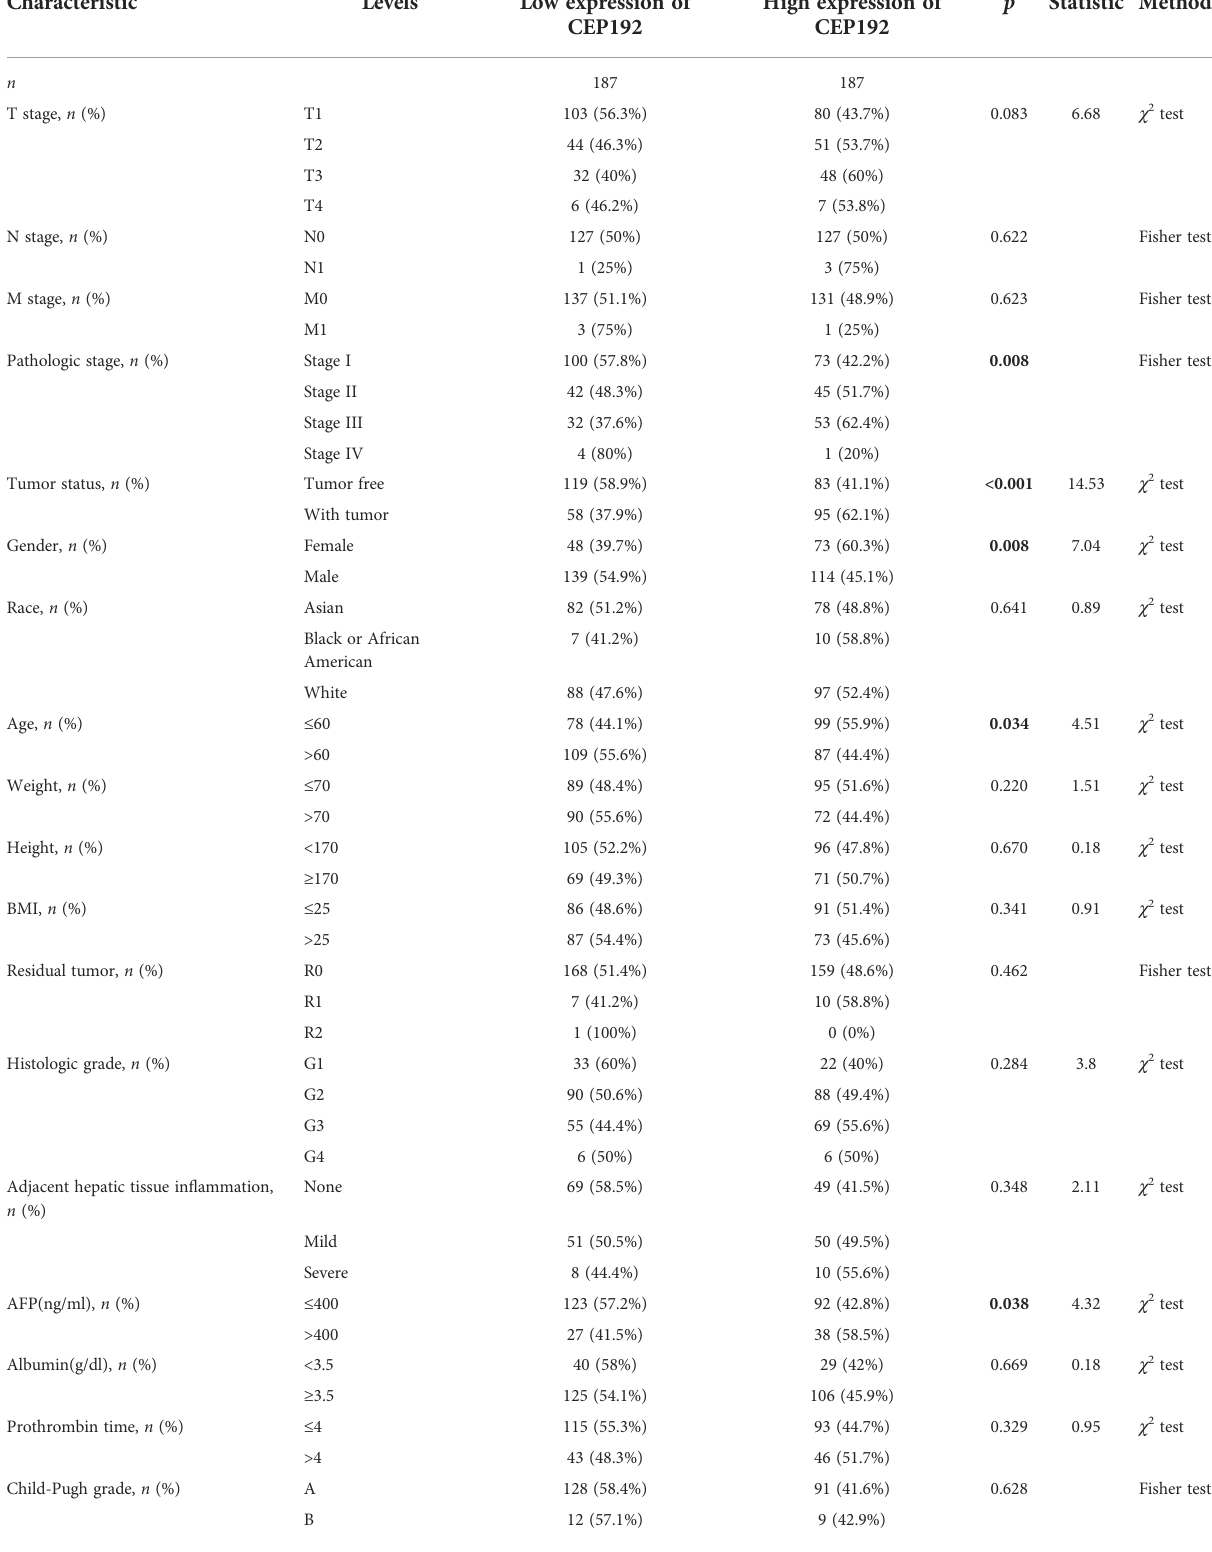
TABLE 1 Correlations between CEP192 expression and clinical characteristics of HCC patients.